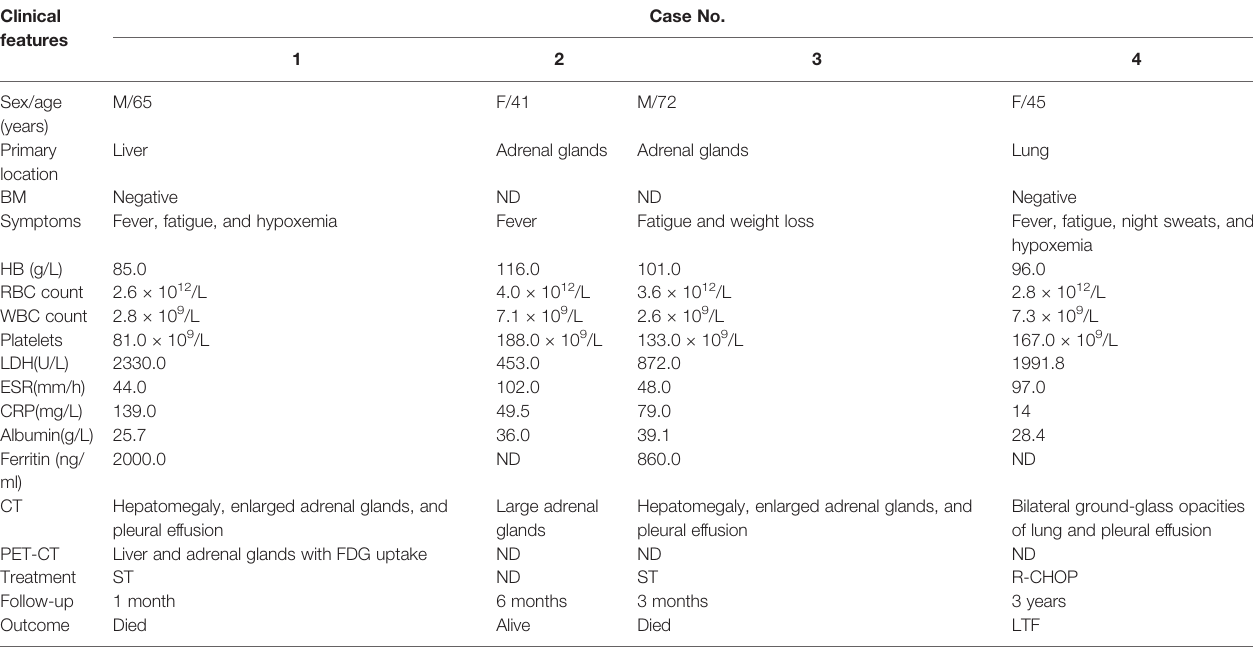
TABLE 1 | Clinical features of four cases of IVLBCL. Clinical